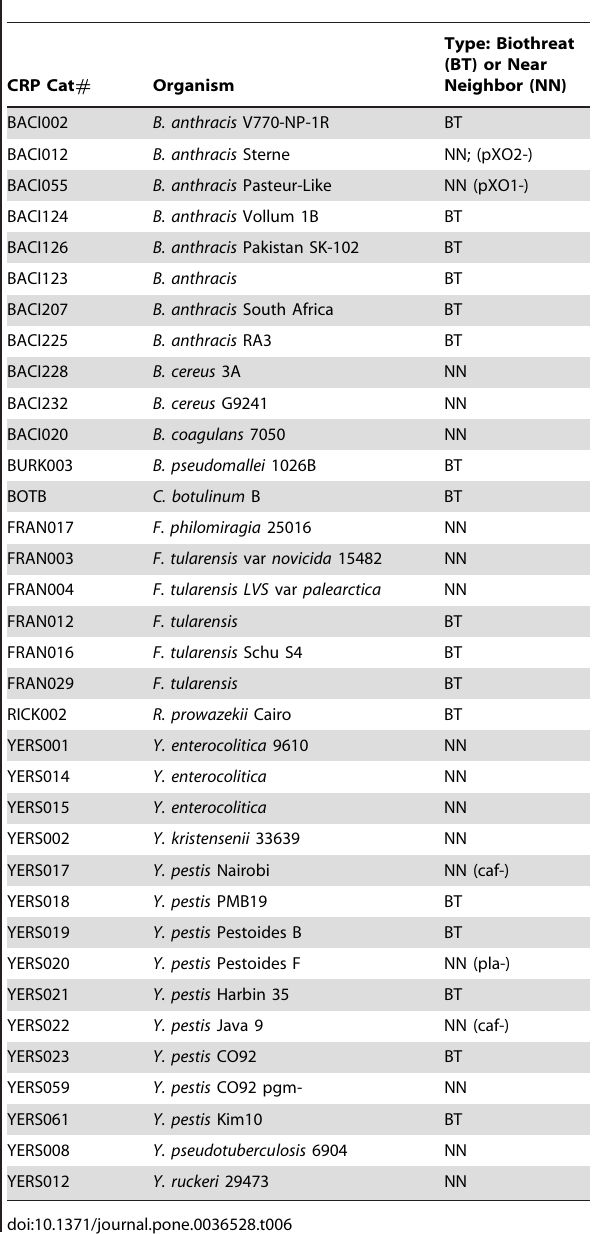
Table 6. Organisms appropriately detected as threat or near